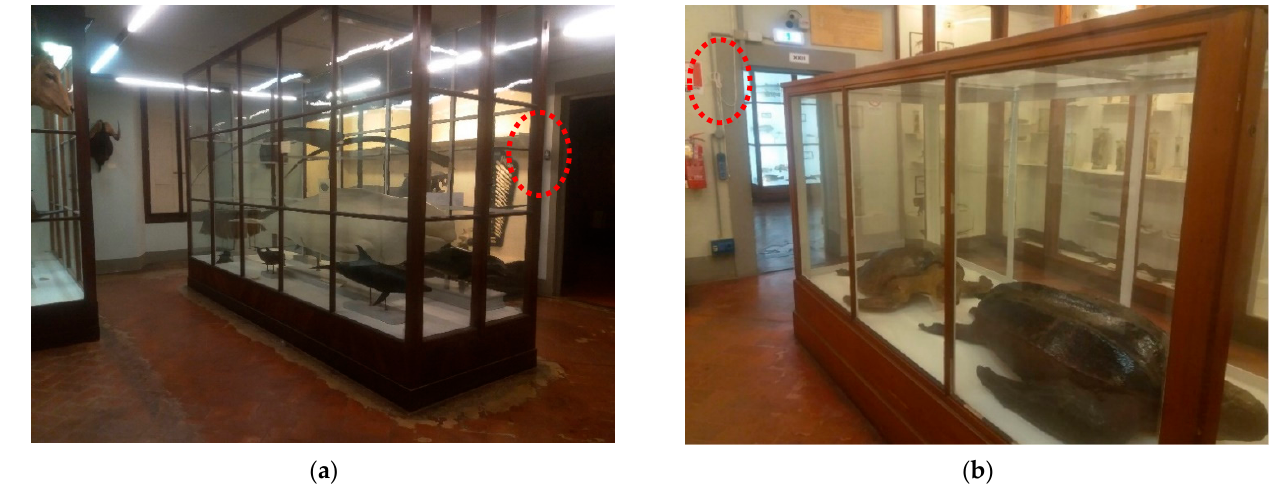
Figure 7. ( a ) Pictures of the dataloggers in room X and ( b ) room XXII.